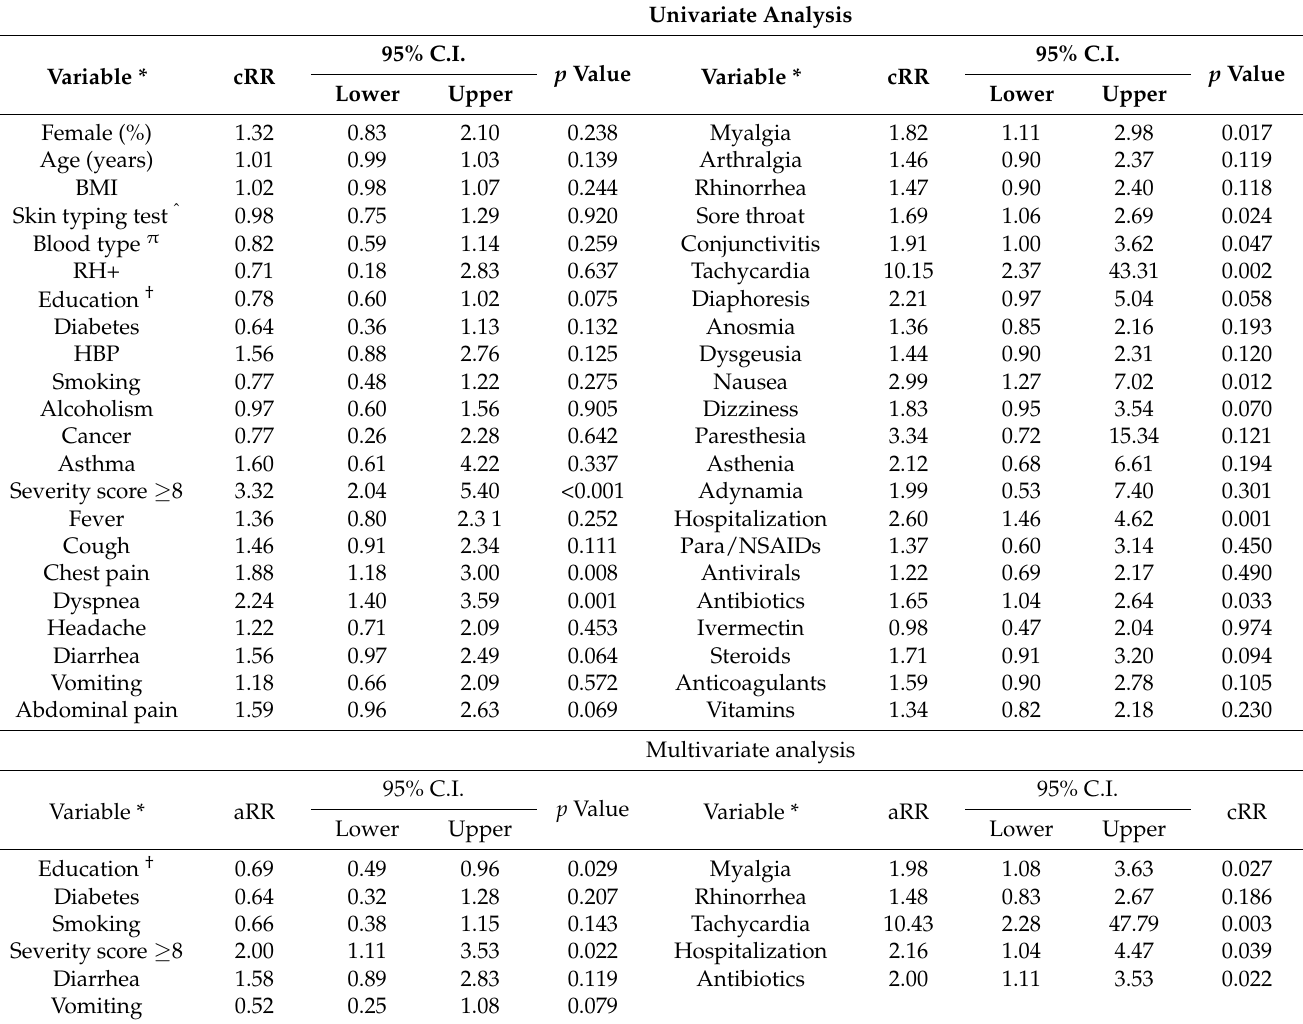
Table 4. Univariate and multivariate logistic regression analyses of factors associated with long COVID in the acute phase of the disease. Univariate